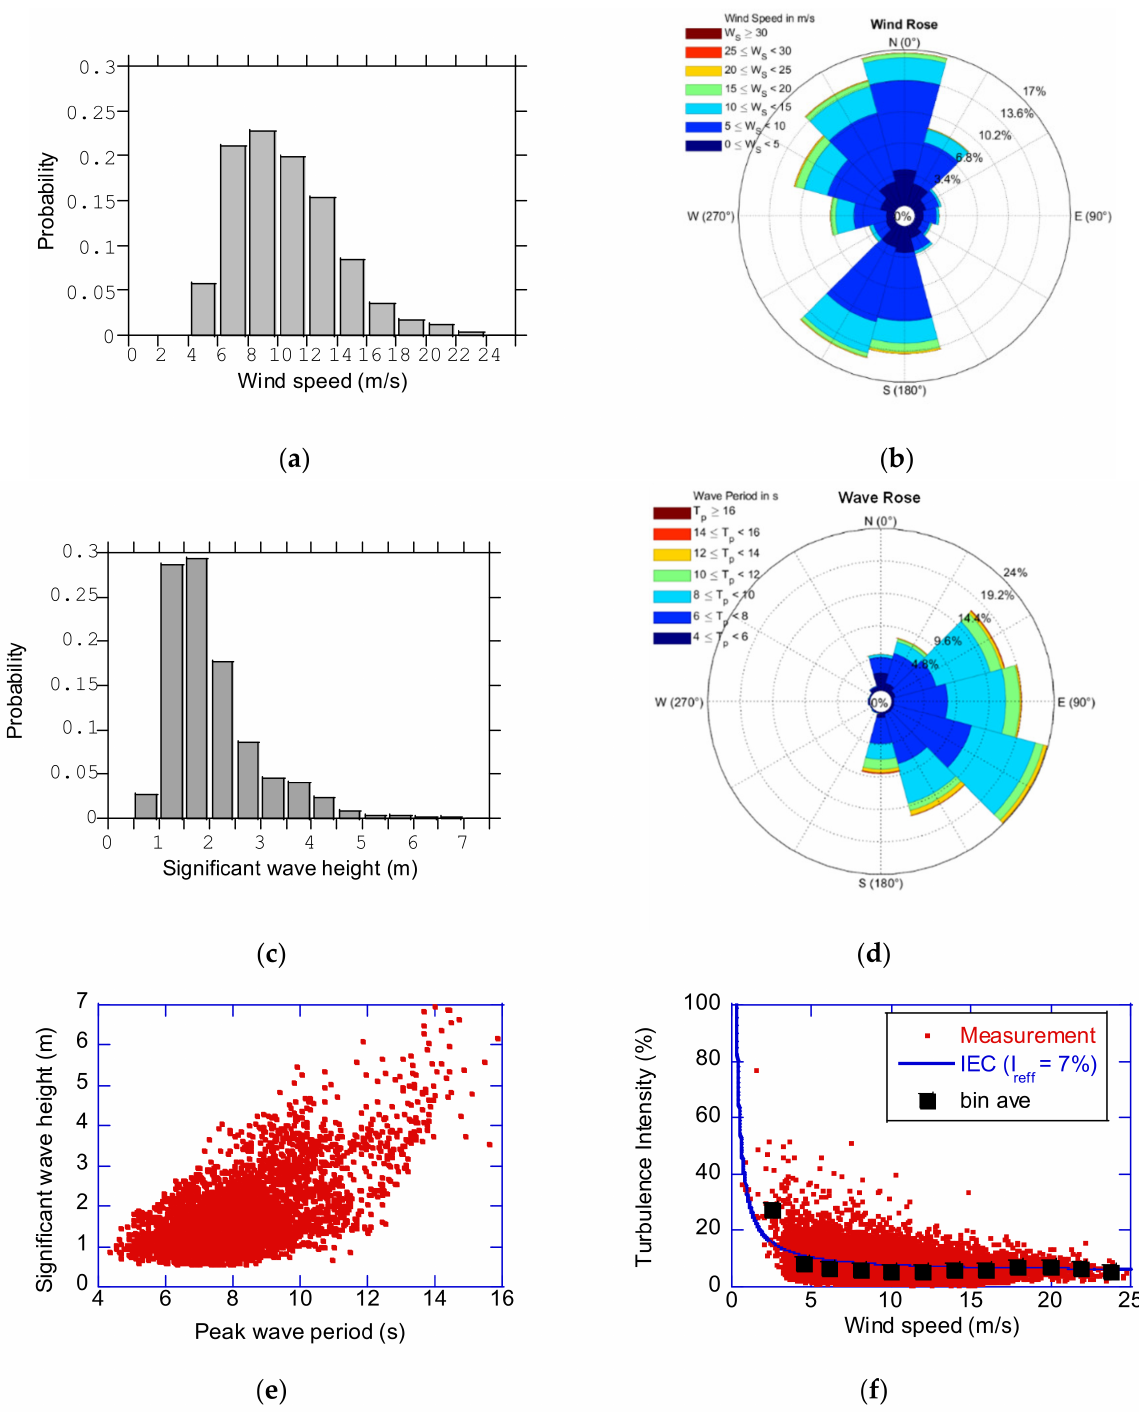
Figure 5. Metocean condition at the Fukushima site: ( a ) wind speed frequency distribution; ( b ) wind rose; ( c ) wave height frequency distribution; ( d ) wave rose; ( e ) relationship between peak wave period and significant wave height; ( f ) turbulence intensity as function of mean wind